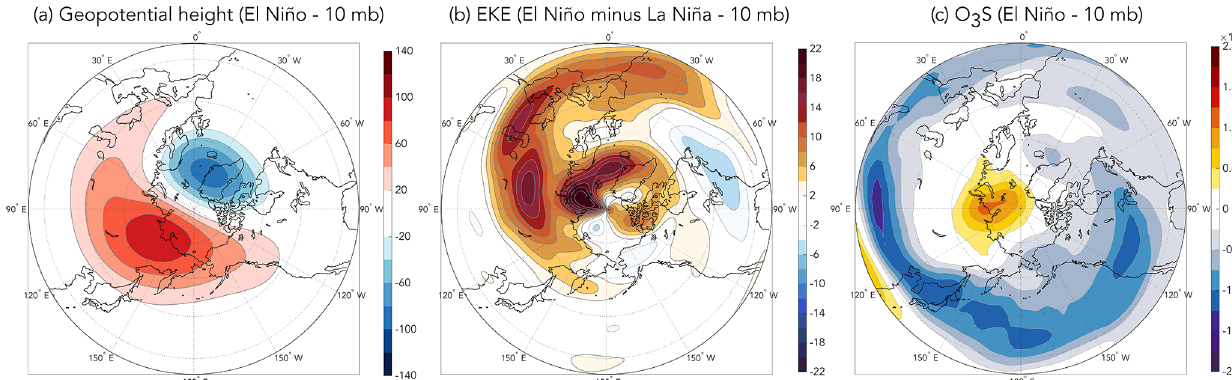
Figure 2. February–March 10hPa anomaly composites of (a) geopotential height (units: gpm, geopotential meter) for El Niño, (b) eddy kinetic energy (2 to 120d filtered, units: m 2 s − 2 ) for El Niño minus La Niña, and (c) stratospheric O 3 S (units: mass mixing ratio) for El Niño. All figures are plotted on the 10mbar pressure